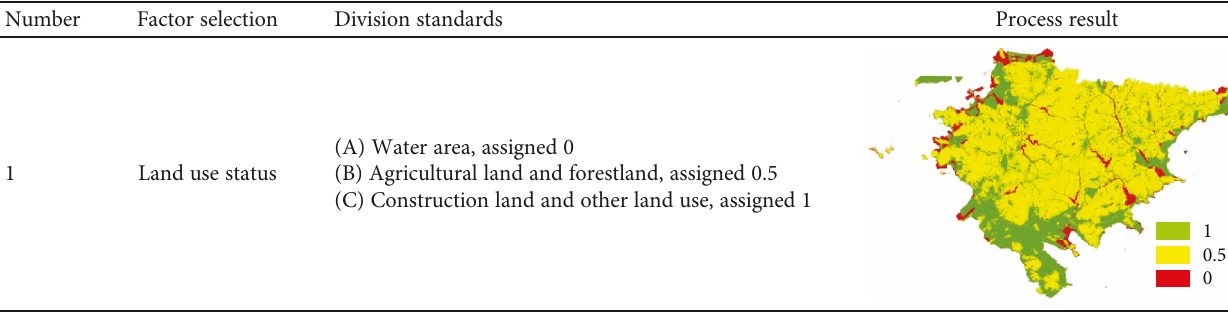
Table 4: Selection and processing of natural